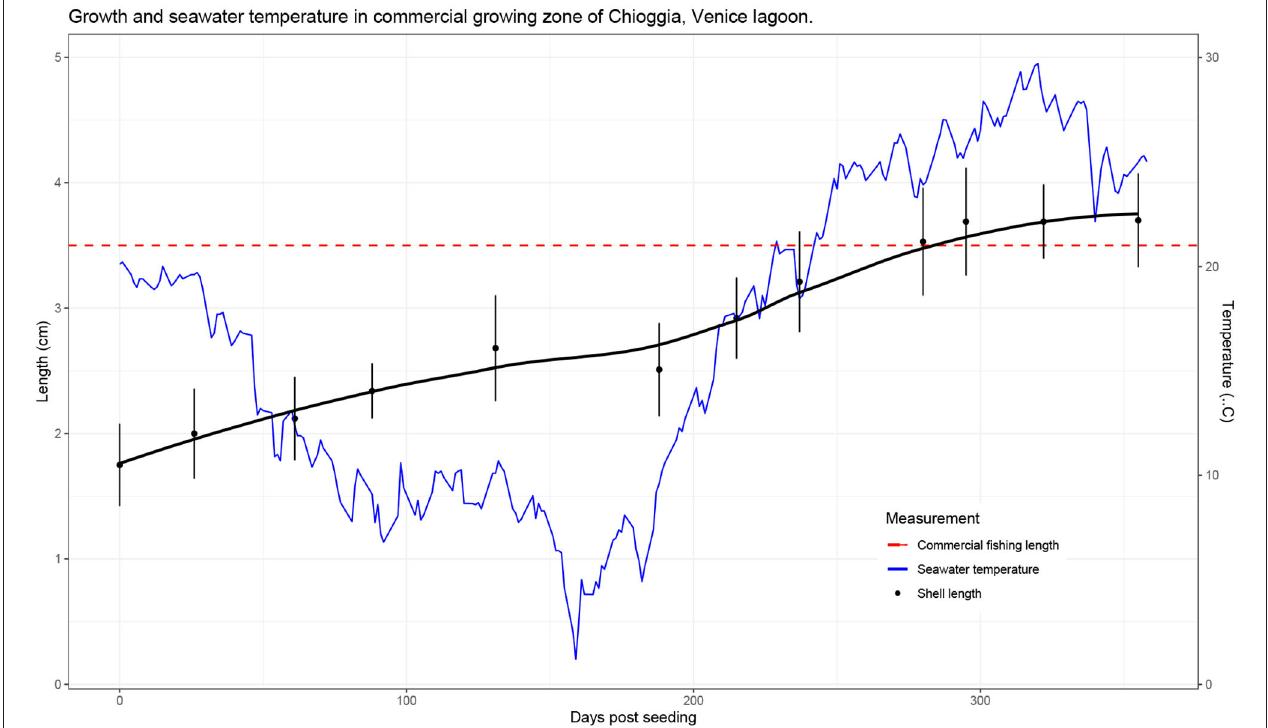
FIGURE 2 | Clam growth (shell length) as recorded from September 2017 to August 2018 (355 days total). Shell length is the mean value measured at each time point, and error bars represent standard deviations. Temperature measurements were recorded daily by the Hydrobiological Station of Chioggia at the entrance of the lagoon (records available at: https://chioggia.biologia.unipd.it/en/the-database/parameters-of-lagoon/).